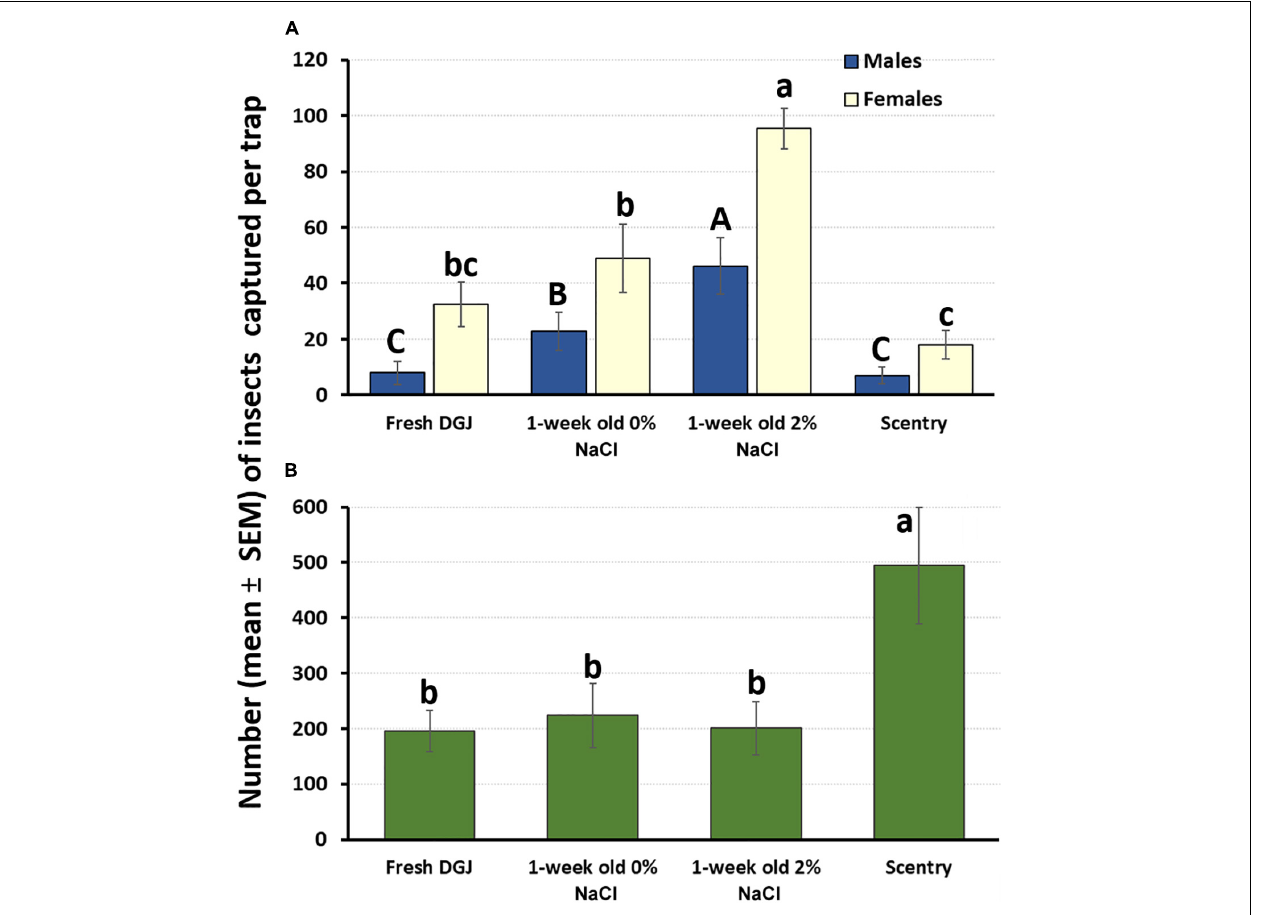
FIGURE 7 | Captures (means ± SEM) of (A) male and female D. suzukii and (B) other drosophilids in traps baited with diluted Concord grape juice (DGJ) either, fresh or aged for 7 days with 0 and 2% of NaCl added prior to fermentation vs. Scentry R (cid:13) SWD lures. Study conducted in a commercial cherry block at the University of Massachusetts Cold Spring Orchard (Belchertown, MA) from 1 June to 17 July 2021. For each sex of D. suzukii , different letters indicate significant differences according to ANOVA and Tukey HSD tests at P =